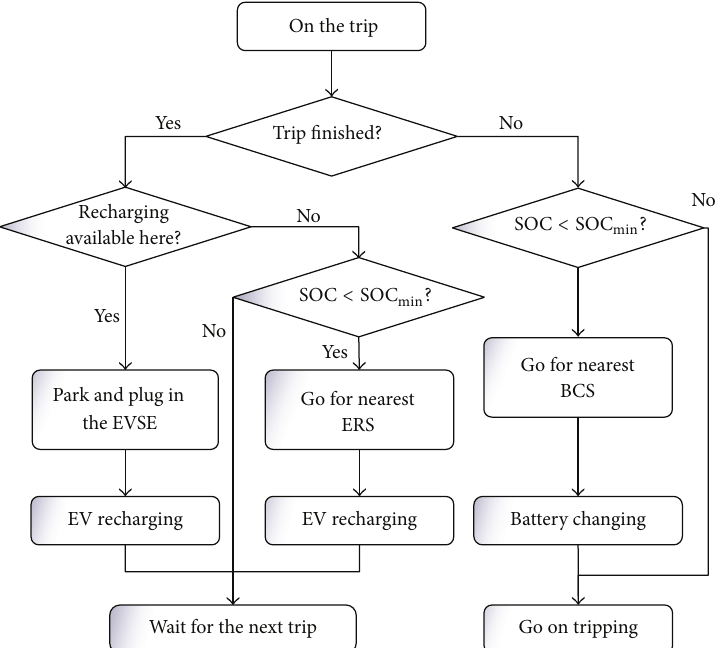
Figure 6: Decision process for EV driver.